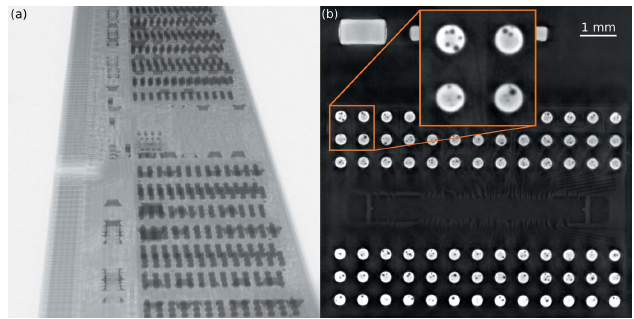
Figure 9 Flip-chip solder bump defects investigation in a DDR3 memory module by cone beam laminography. Projection image ( a ); reconstructed absorption slice ( b ) with a zoomed region showing some of the discovered defects.